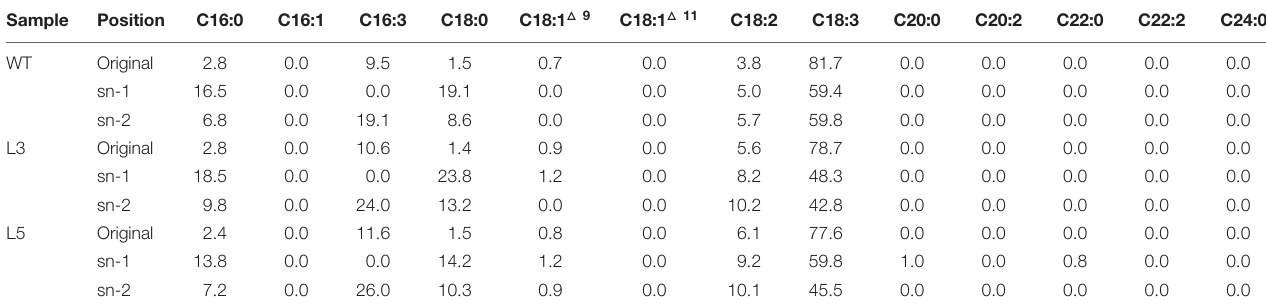
TABLE 2 | Positional distribution of fatty acids in MGDG of potato senescent leaves.